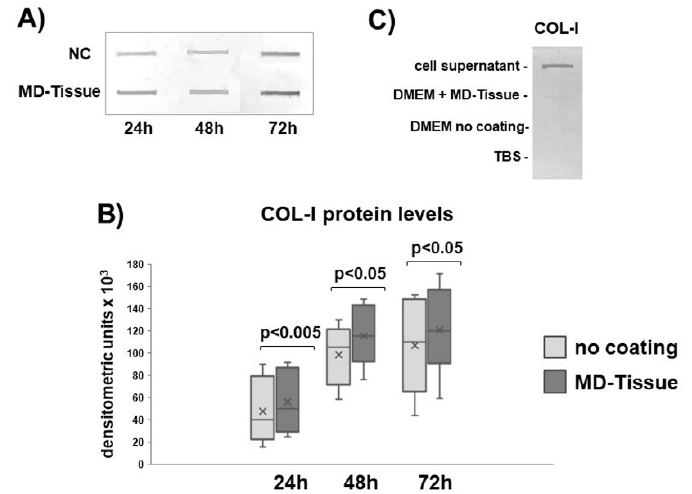
Figure 4. Representative slot blot analysis for collagen type I (COL-I) expression ( A ) expression in cell-culture medium of tenocytes cultured without coating (NC) or on MD-Tissue. Bar graphs displaying COL-I ( B ) protein levels analyzed densitometric scanning of immunoreactive bands in panel A. Data are expressed as mean ± SD for the 8 samples. ( C ) Slot blot analysis for COL-I showing that COL-I expression originates from tenocytes. ×: mean.